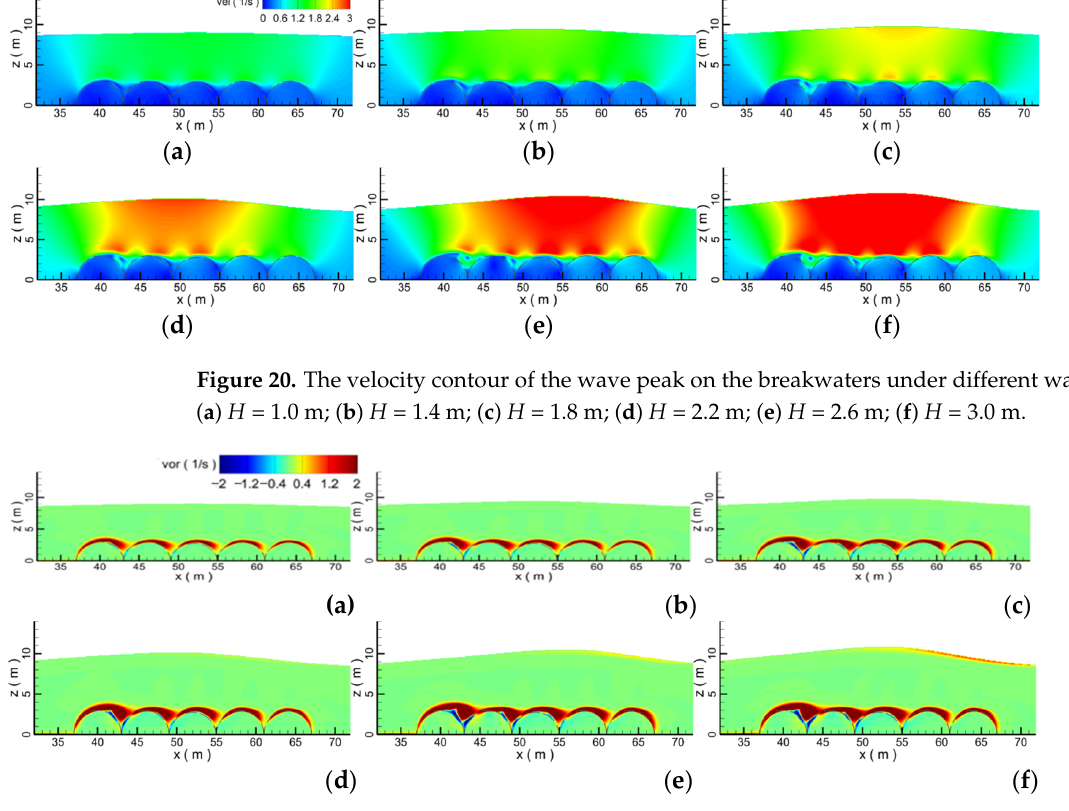
Figure 21. The vorticity contour of the wave peak on the breakwaters under different wave heights; ( a ) H = 1.0 m; ( b ) H = 1.4 m; ( c ) H = 1.8 m; ( d ) H = 2.2 m; ( e ) H = 2.6 m; ( f ) H = 3.0 m.